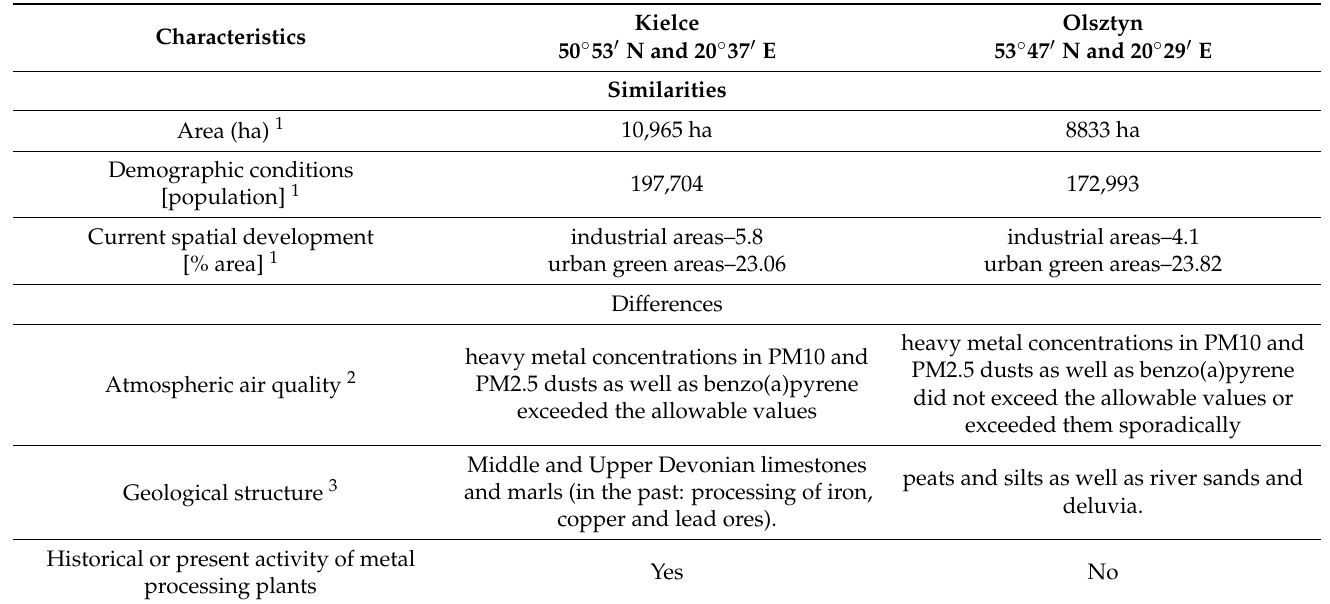
Table 1. Cities selected for the study along with comparative